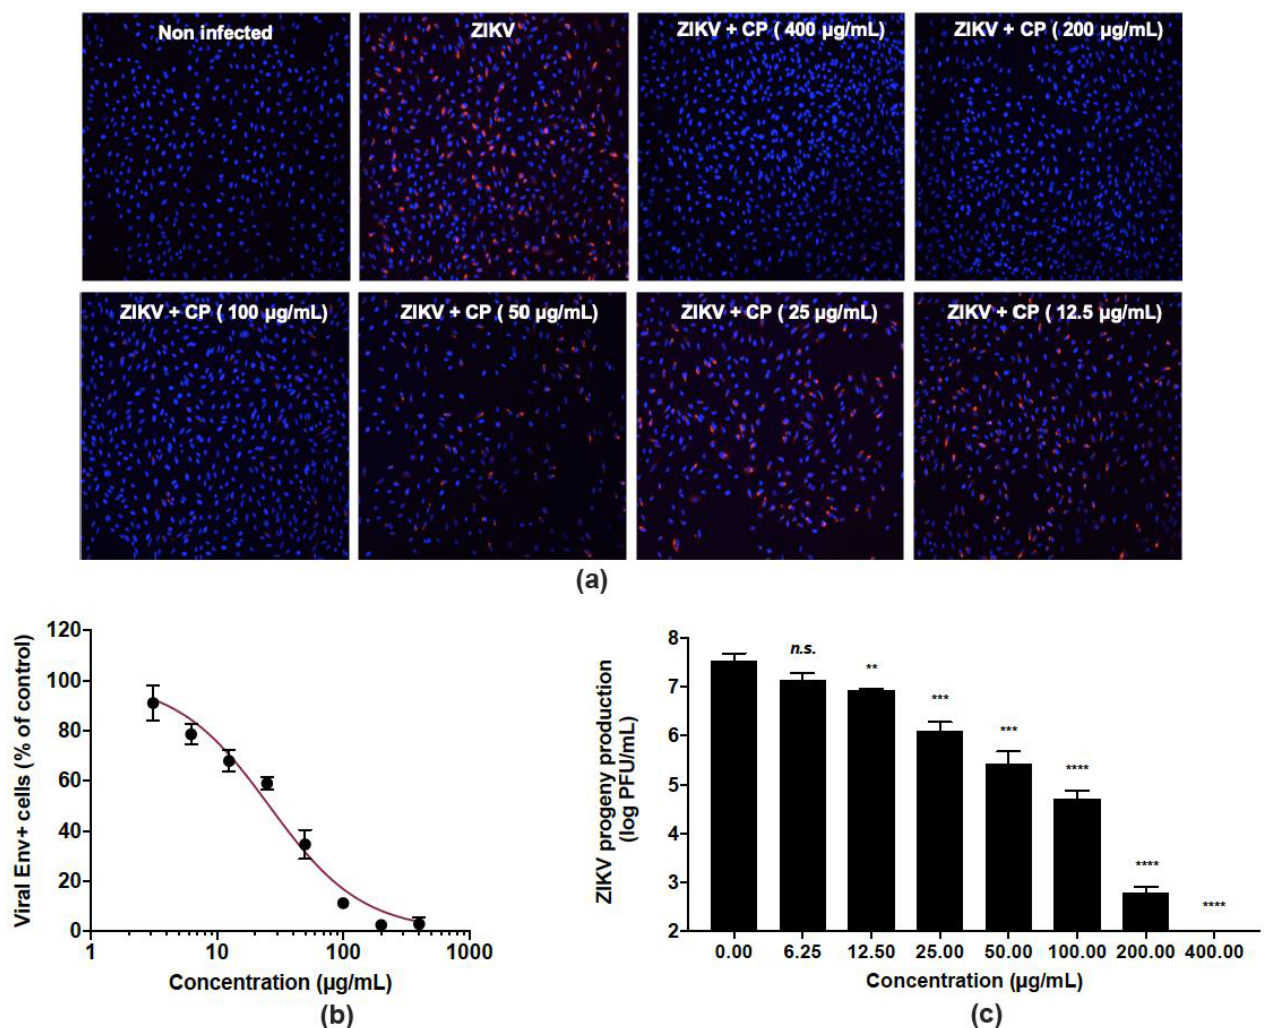
Figure 3. Cranberry pomace extract exhibits dose-dependent antiviral effect against the epidemic strain of ZIKV. A549 cells were challenged with the epidemic strain of ZIKV (PF-25013-18) at an MI of 2 and simultaneously treated with various non-cytotoxic concentrations of CP extract (0 – 400 µg/mL). ( a ) Immunofluorescence analysis of viral protein expression in A549-ZIKV-PF13-infected cells. The ZIKV E (red) and nuclei (blue) were visualized by fluorescence microscopy. Images are representative of three independent experiments. ( b ) Quantification of the number of cells positive for the viral protein E expression in A549-ZIKV-infected cells by immunofluorescence. ( c ) ZIKV growth was assessed by a plaque formation assay. Results from a representative experiment ( n = 3 repeats) are shown. Data are means ± SD of three separate experiments. One-way ANOVA and Dunnett ’ s test were used for statistical analysis (** p < 0.01; *** p < 0.001; **** p < 0.0001; n.s. = not significant).